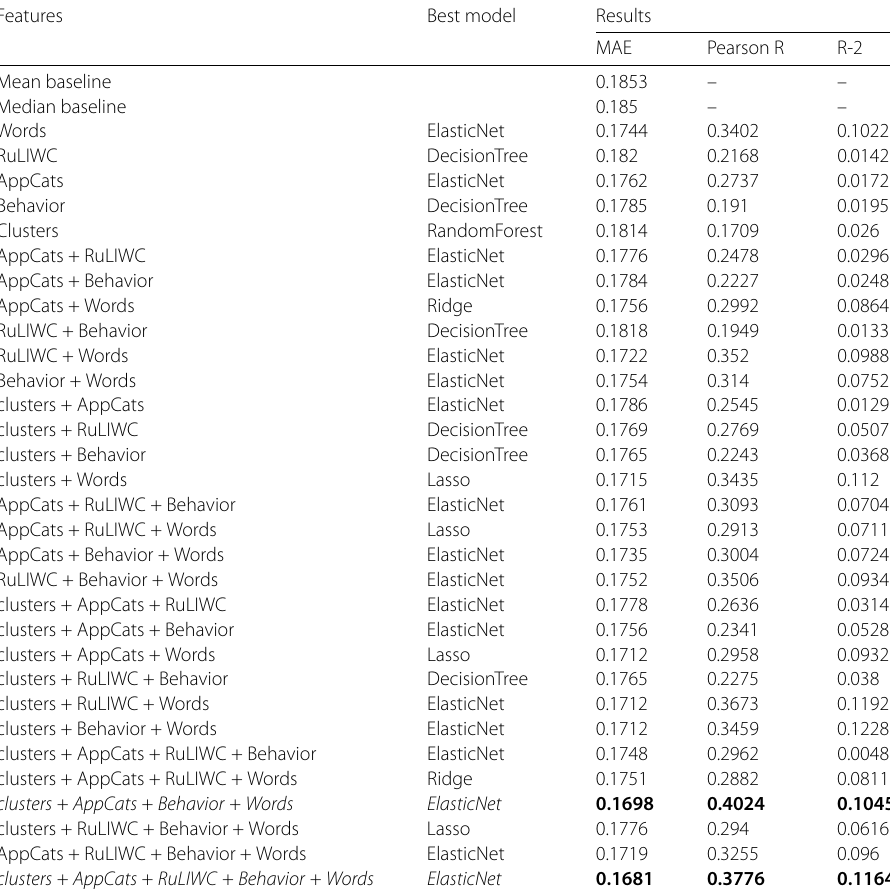
Table 19 SWLS regression results for all feature sets